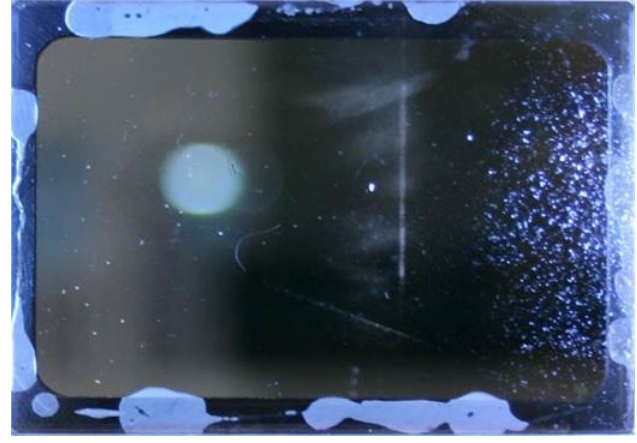
Figure 4. The damaged pick-off mirror BM7.